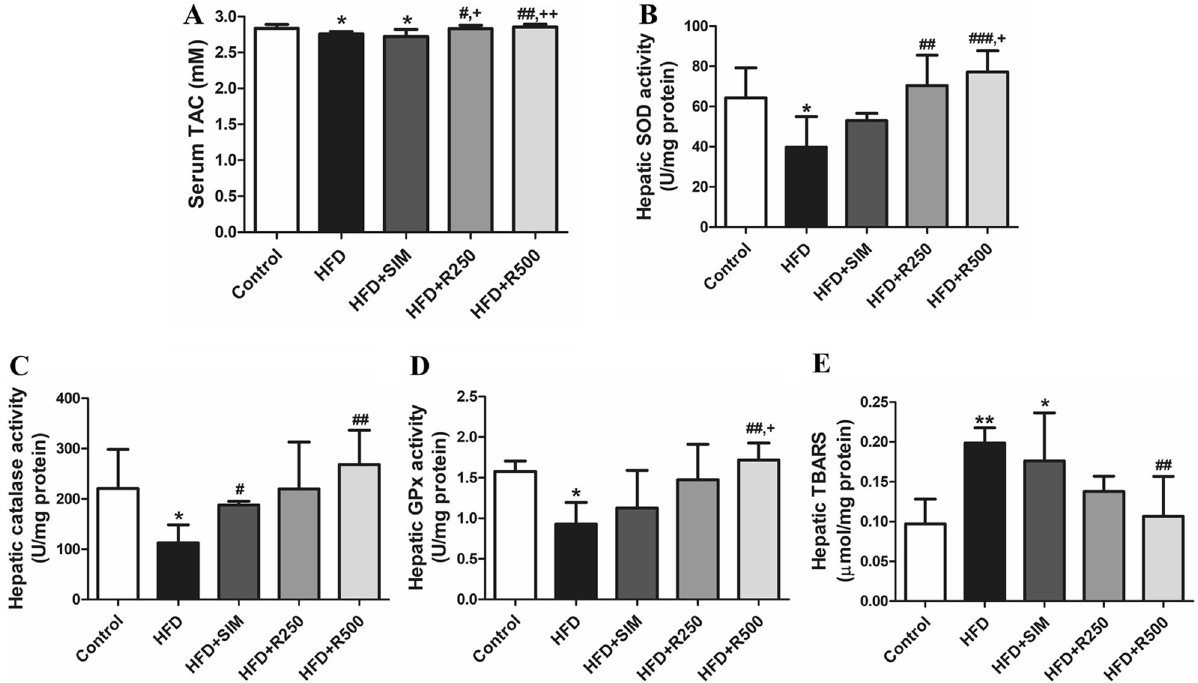
Figure 4. Roselle extract improves antioxidant enzymes and ameliorates lipid peroxidation in liver sample in rat fed high fat diet. ( A ) serum TAC, ( B ) hepatic SOD, ( C ) hepatic catalase, ( D ) hepatic GPx, and ( E ) hepatic TBARS. Data were represented as means ± SD from three replications (n = 5 to 7 per group). Statistical analysis was performed with one-way ANOVA followed by Tukey’s post hoc test. The mean differences were significant compared with the control group (* P < 0.05, ** P < 0.01), HFD group ( # P < 0.05, ## P < 0.01, ### P < 0.001) and HFD + SIM group ( + P < 0.05, ++ P <